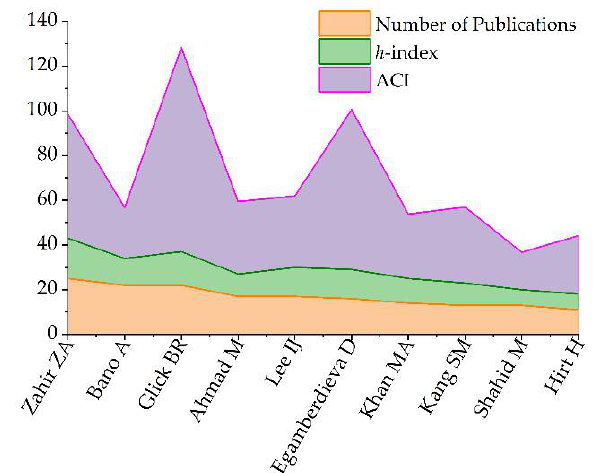
Figure 4. The number of publications (NP) of the top 10 most productive authors and their corre- sponding h– index, ACI.